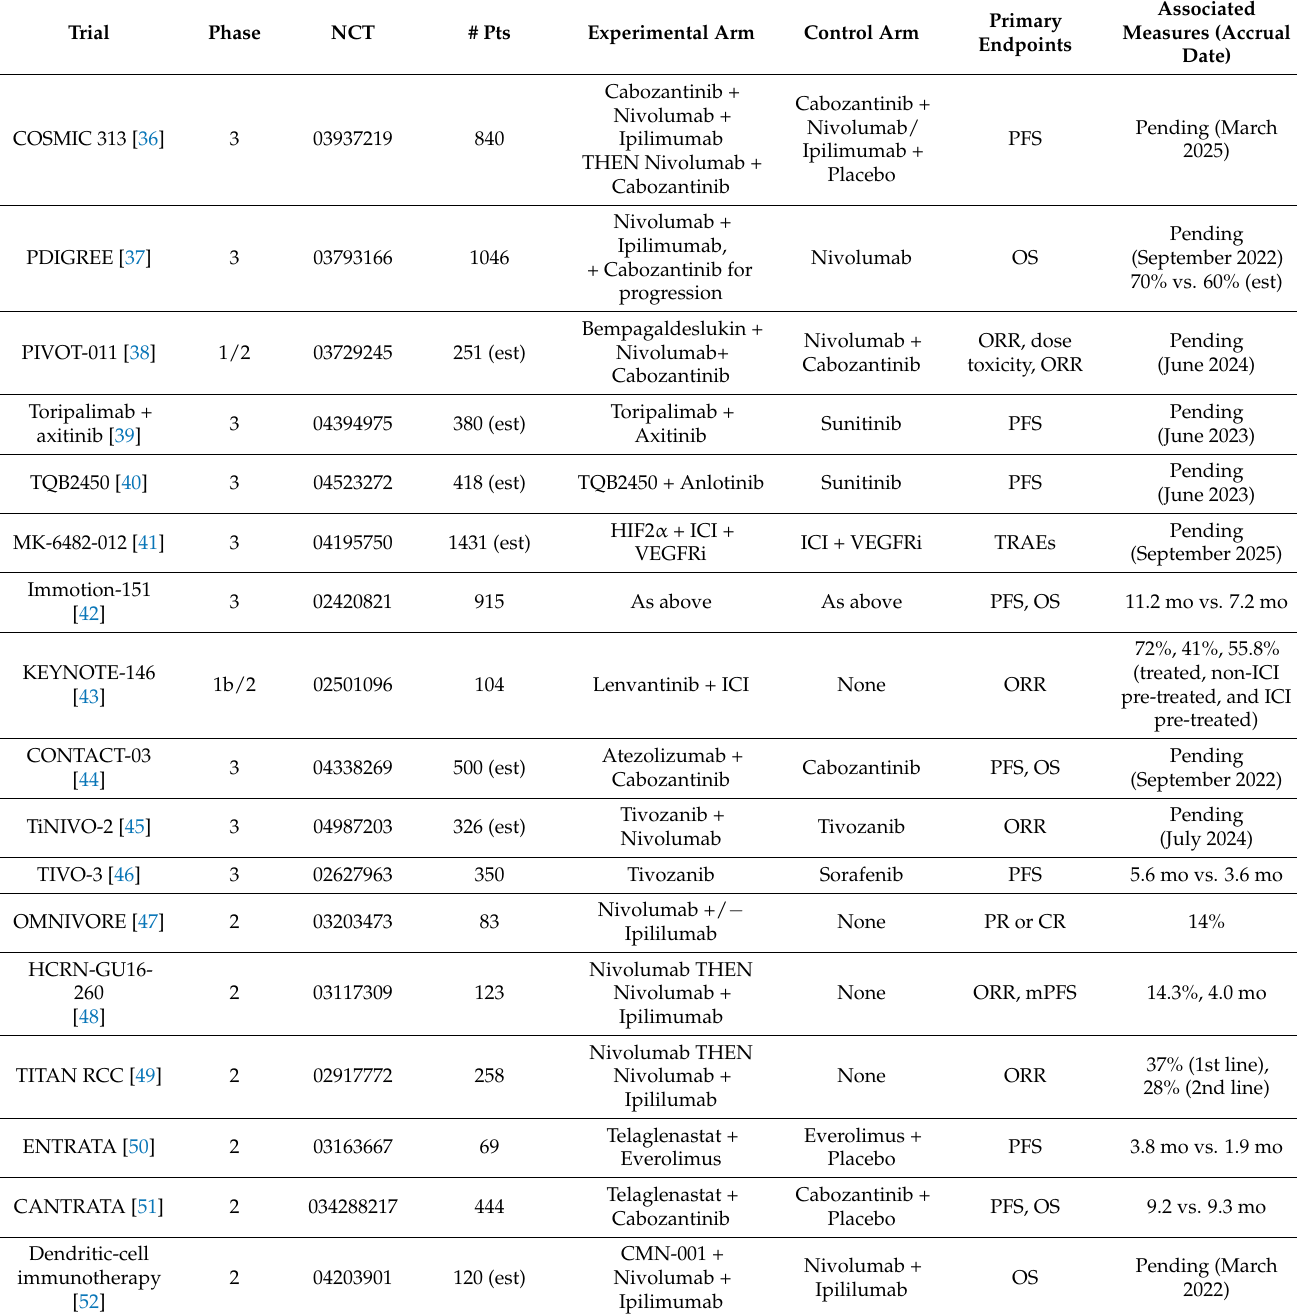
Table 2. Tabulation of ongoing therapies in metastatic renal cell